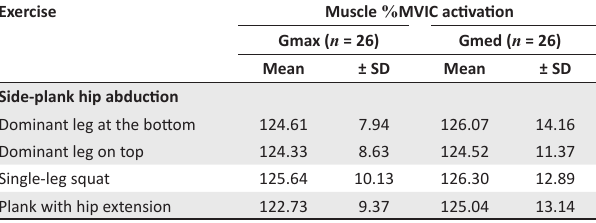
* , F-statistics, p -value and effect size statistic from three-way analysis of variance (ANOVA) model with ‘participant’ and ‘exercise’ as fixed effects. MVIC, maximal voluntary isometric contraction; df , degrees of